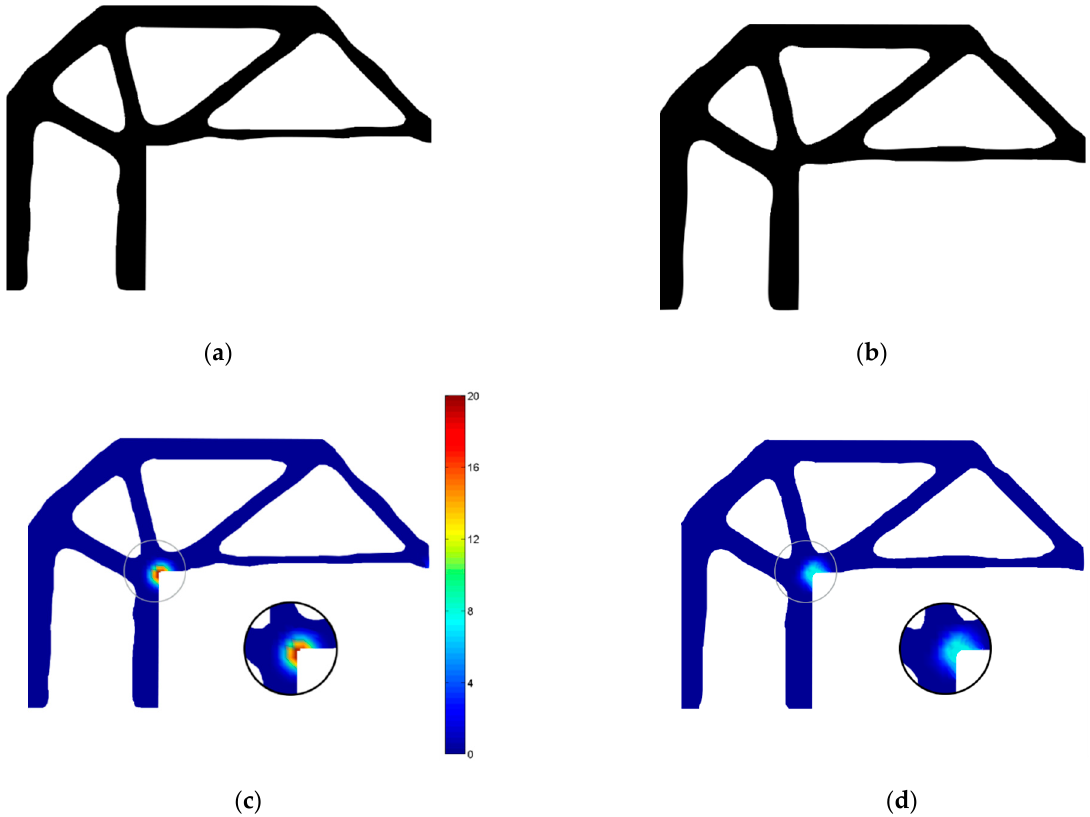
Figure 11. Convergence history of C-shaped bracket considering porosity constraint.